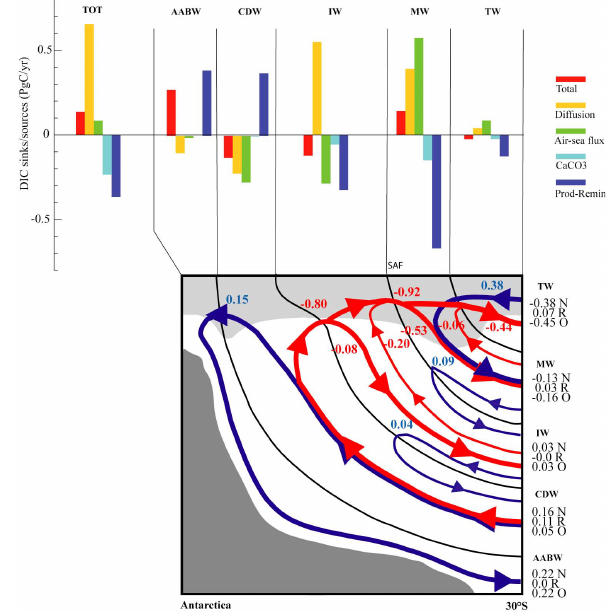
Fig. 7. Upper panel: budget (PgCyr − 1 ) per water masses of the sources/sinks of DIC Eq. (2). Lower panel: DIC sources/sinks as- sociated with the different branches of the overturning circulation (PgCyr − 1 ). The numbers along the vertical column correspond to: the gain/loss of DIC when the water mass leaves the Southern Ocean at 30 ◦ S (N), the gain/loss of DIC for the recirculation (R); and the gain/loss of DIC for the overturning. At the surface there are the air-sea CO 2 fluxes (PgCyr − 1 ) for each water mass com- puted considering the winter density while in parenthesis are the flux computed without considering the winter density. The light blue arrows indicate the fluxes toward the ocean while the magenta arrows indicate the fluxes toward the